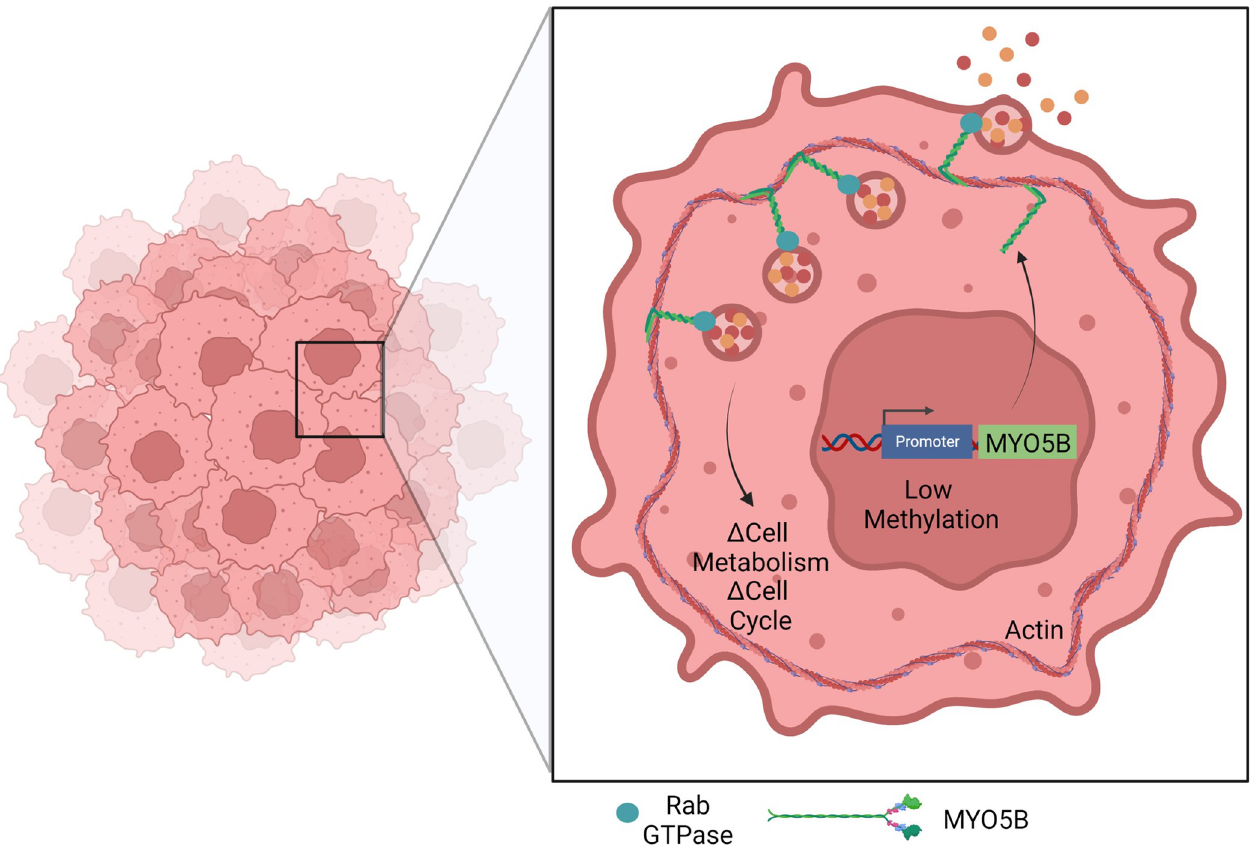
Fig 8. Model diagram of current findings. We speculate that low methylation of the MYO5B promoter enhances the gene expression of MYO5B and elevates levels of MYO5B protein. MYO5B binds to Rab GTPases to transport cargo in UCEC tumors and thereby contributes to altered cell metabolism and cell cycle. Created with